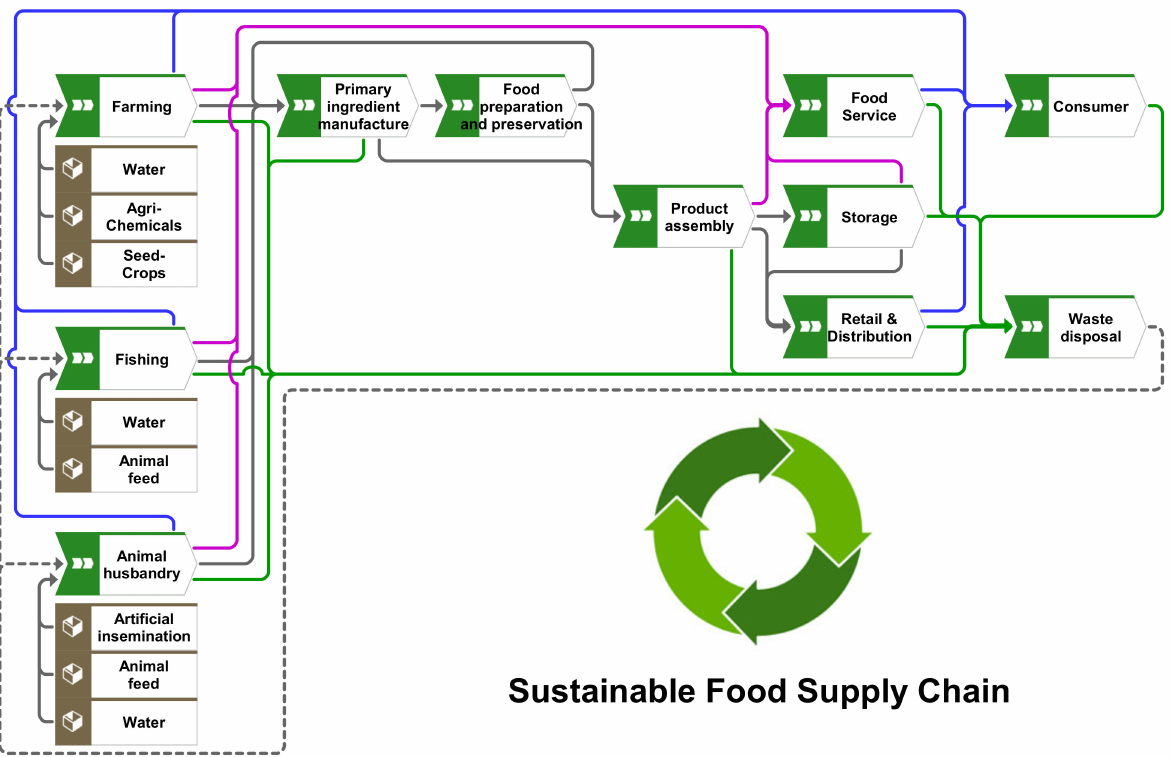
Figure 1. Sustainable food supply chain. Source: own work